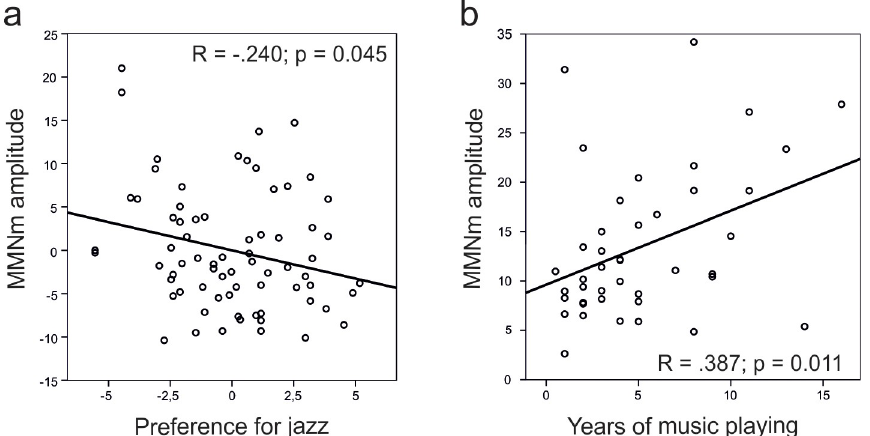
Fig 4. Correlation plots. (a) Significant partial correlation between right hemisphere MMNm amplitudes to slide and preference for jazz music (left) in non-musicians and amateurs (NM + AM) controlled for preference for classical music (corrected data plotted); (b) Significant correlation between years of music playing and right hemisphere MMNm amplitude to